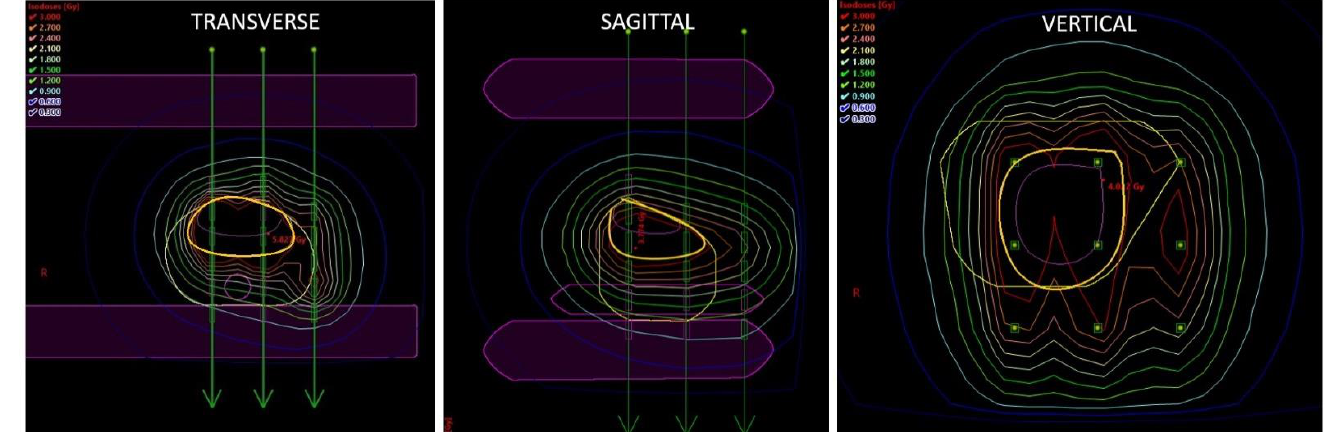
Figure 2. Dose distribution. The simple geometrical 3D model was created in the BrachyVision plan- ning system (Varian Medical Systems, Palo Alto, CA, USA) by measuring the distance between both plates, between each needle tip and plate, and between plates and the musoca entry and exit point for each needle. The urethra was modeled as a straight tube. The width of the plates was 1 cm, and the needle separation was 10 mm in square grid geometry. Purple contour = GTV; ochre contour = CTV; yellow contour = penis surface; violet contour = urethra; violet-filled structures = plastic template.